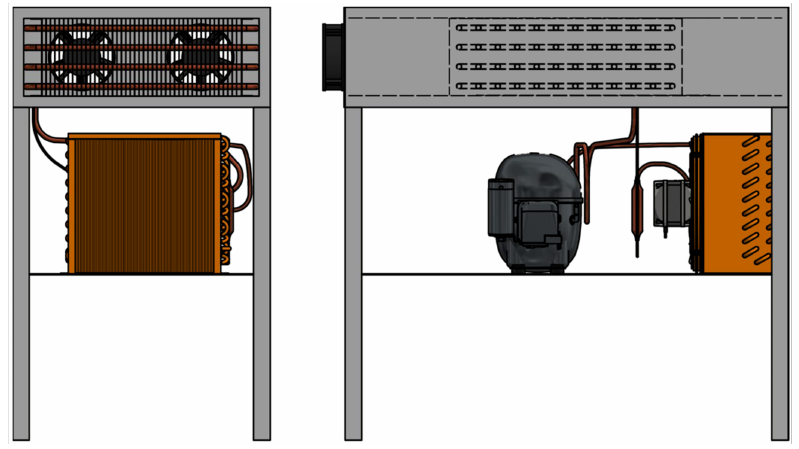
Figure 2. Measurement stand. The device was tested in a climatic chamber maintaining constant air parameters at 25 ◦ C ( ± 1 ◦ C) and 60% relative humidity ( ± 5%). The arrangement of the air-measuring probes is shown below in Figure 3.